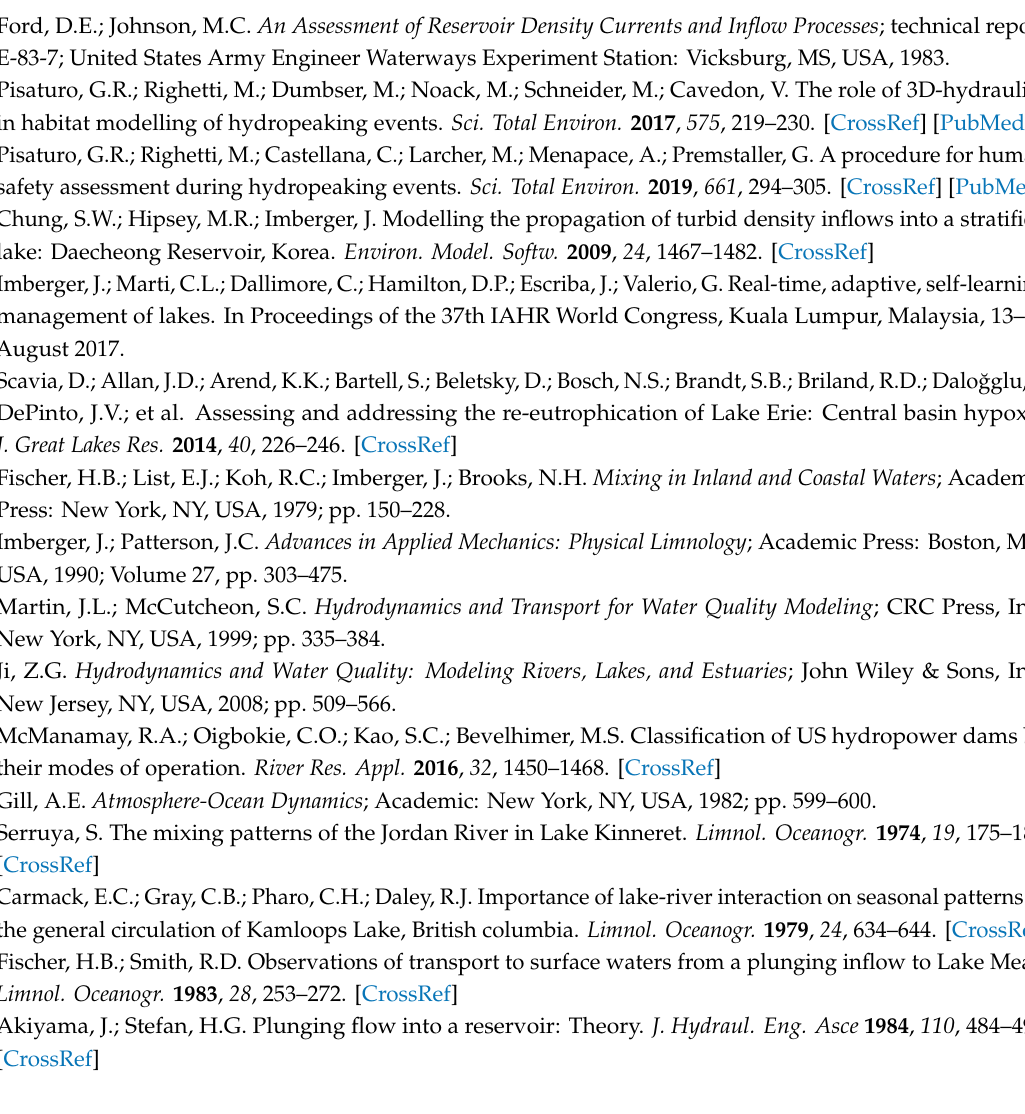
Figure S1: Comparison of observed and simulated value of vertical flow velocity at PC1, PC2, and PC3; Figure S2: Comparison of observed and simulated value of vertical water temperature at PC1, PC2, and PC3; Figure S3: Comparison of observed and simulated value of vertical electrical conductivity at PD4, PD3, and PD2; Figure S4: Box plots showing the cell density of harmful algae observed at site PD2, PD3, and SB from 2012 to 2018; Figure S5: Temporal variations of dissolved oxygen observed by depths at site PD2, PD3, and PD4 from 2012 to 2018; Table S1: Variations of averaged flow velocity, water temperature, water age and electrical conductivity with depths at the station (PD4) in May and June, 2016; Table S2: Variations of averaged flow velocity, water temperature, water age and electrical conductivity with depths at the stations in May and June,